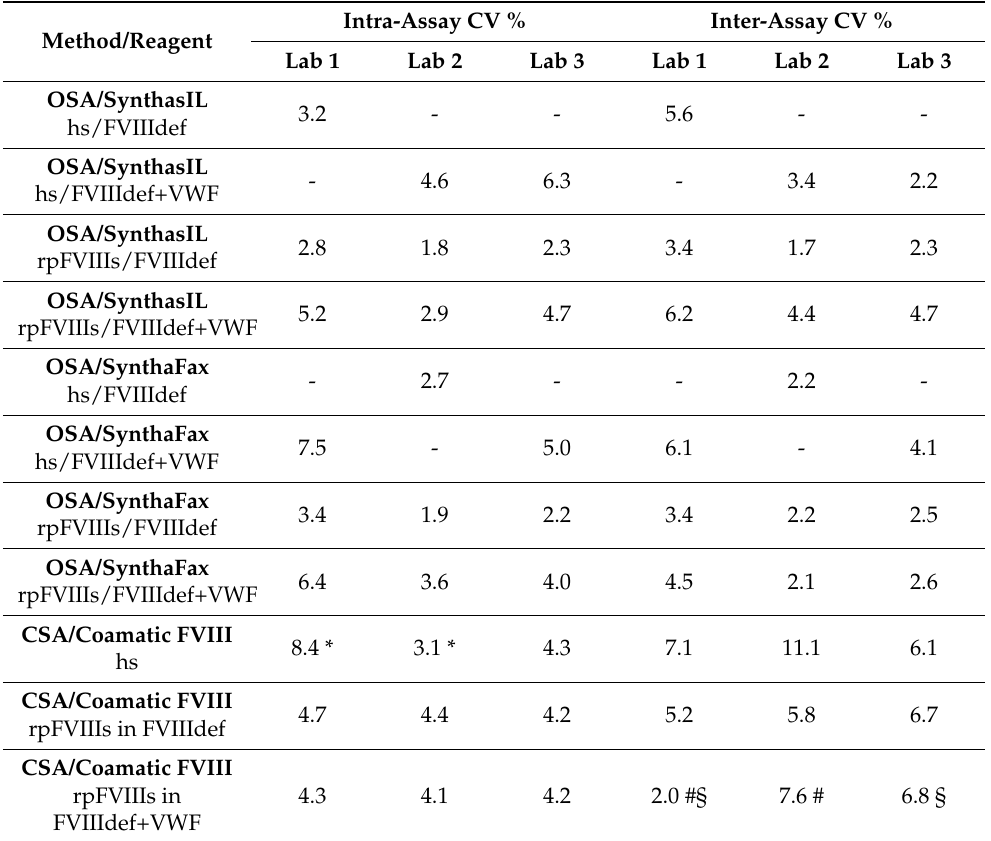
Table 1. Intra- and inter-assay imprecision of all the methods used for rpFVIII measurement.